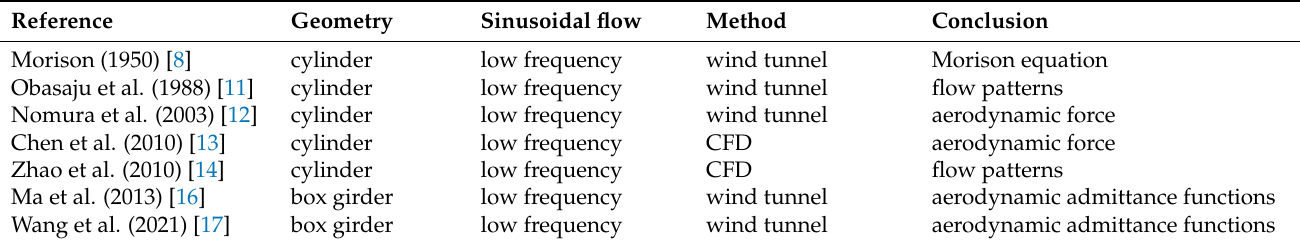
Table 1. Review of the literature on unsteady sinusoidal